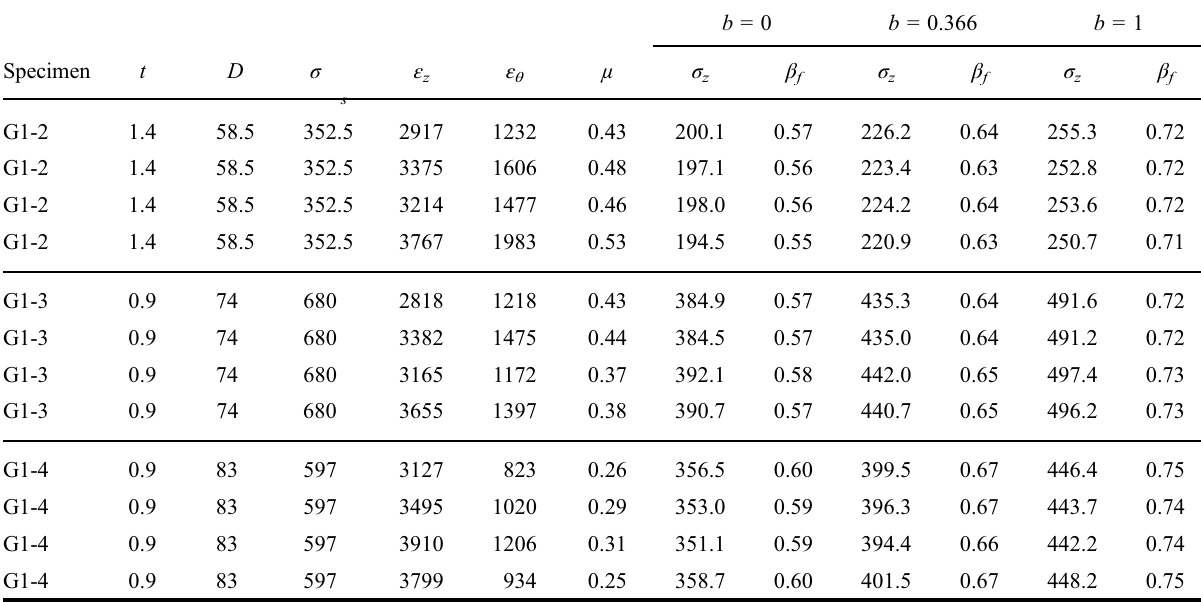
Table 2. Calculation of vertical stress of steel tube under the ultimate state